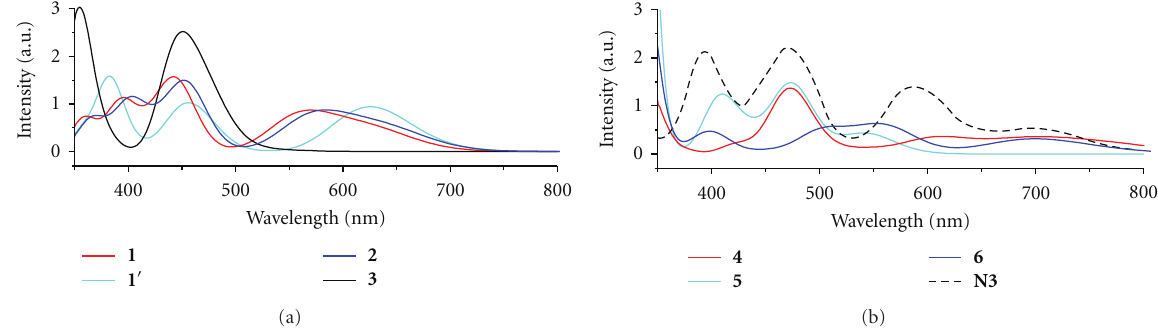
Figure 5: Simulated absorption spectra of Fe(II)-based complexes (solid lines) at the B3LYP/6-31G ∗ level and N3 (dash line) at the B3LYP/SDD level in MeCN